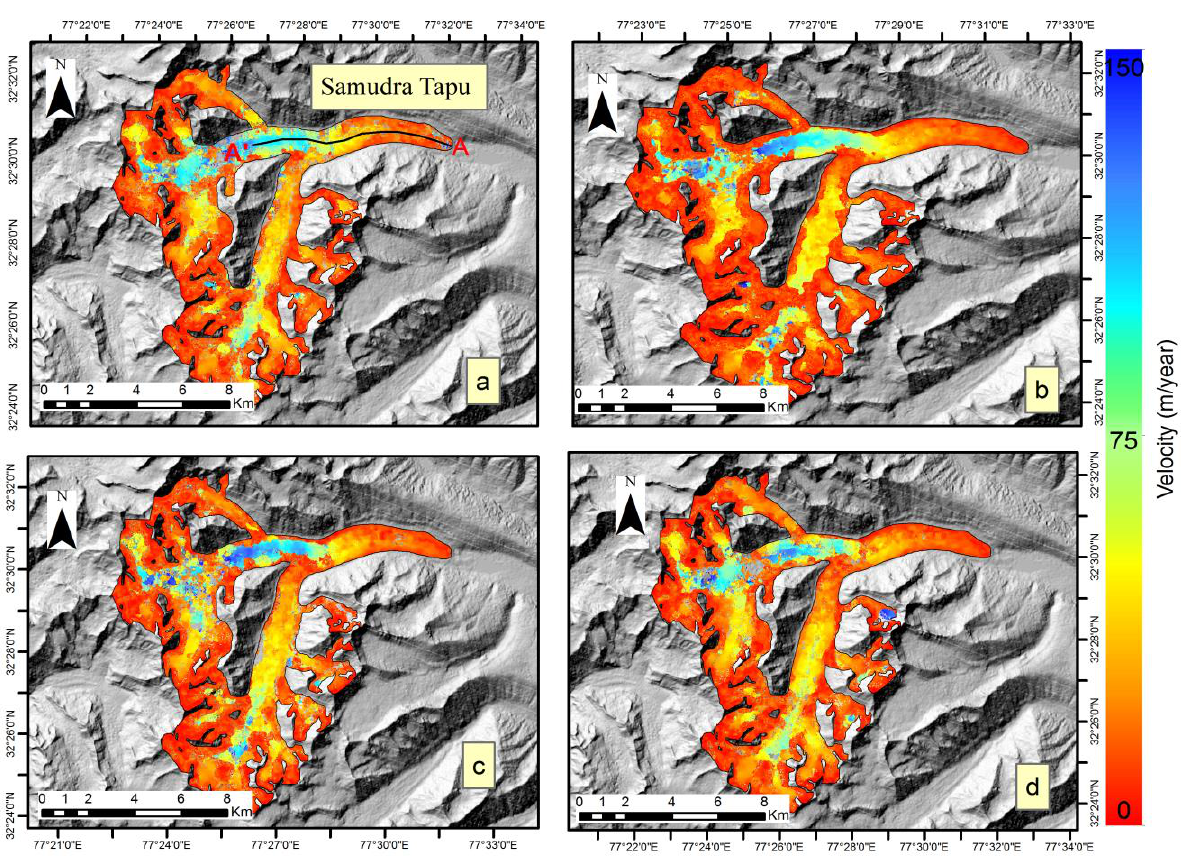
Figure 3. Surface velocity map of Samudra Tapu Glacier for the year (a) 2013-2014; (b) 2014-2015; (c) 2015-2016; (d) 2016-2017, with background image being a hillshade image of SRTM